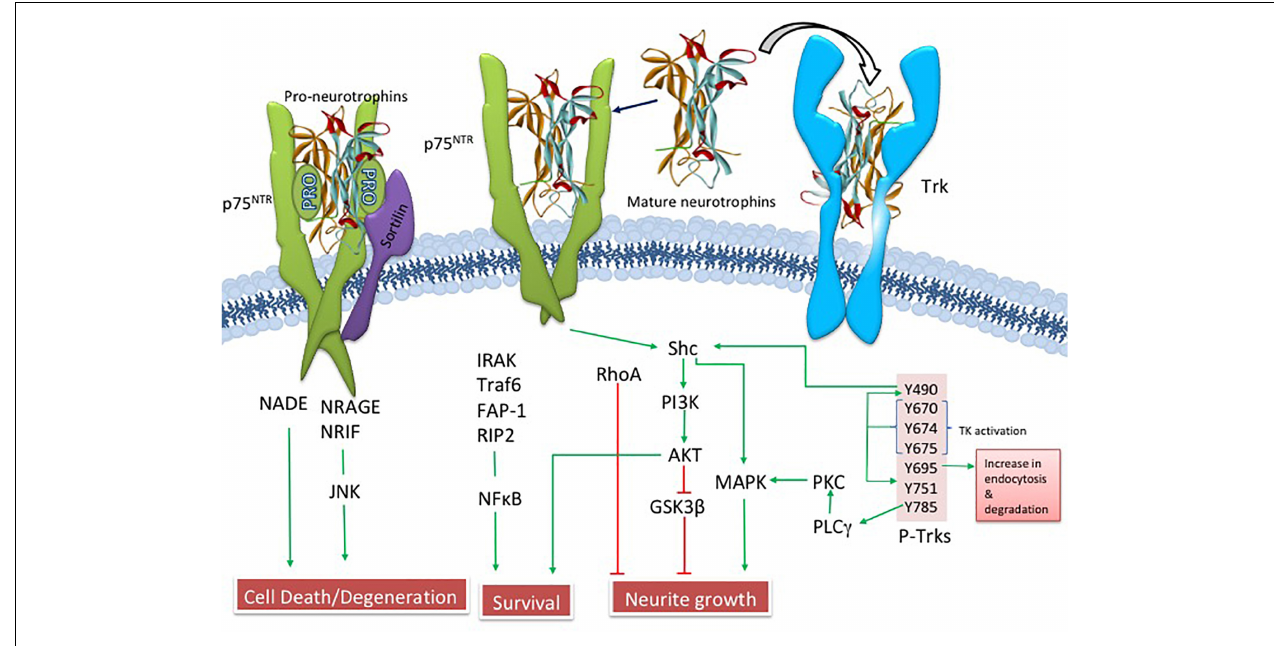
FIGURE 3 | Illustration showing NGF related upstream and downstream pathways.